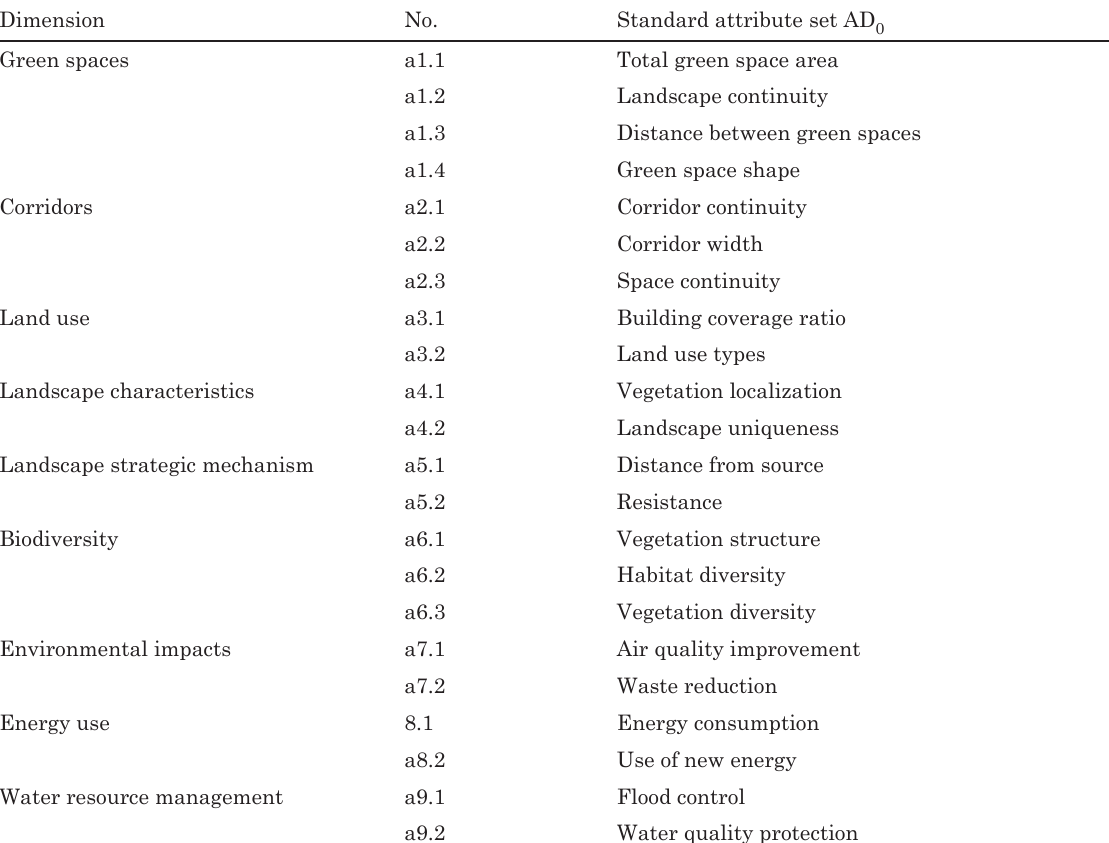
table 1. standard attribute set (aD Dimension no. standard attribute set aD